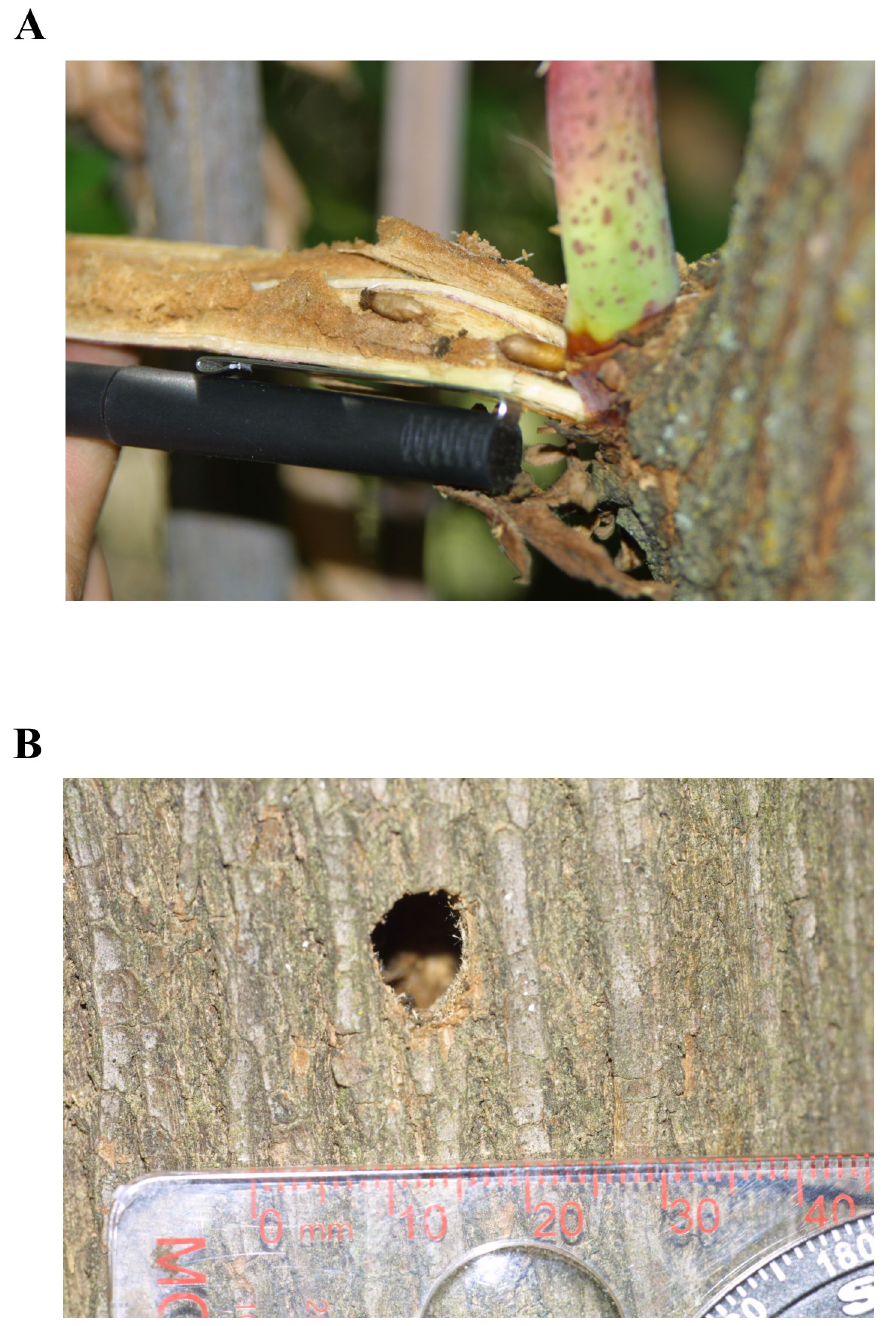
Fig 2. VELB exit holes in elderberry shrubs. A. Archive photo from 1997 showing VELB pupae and frass in a live elderberry stem. B. New (current year) exit hole in elderberry stem from field survey/sampling performed during this